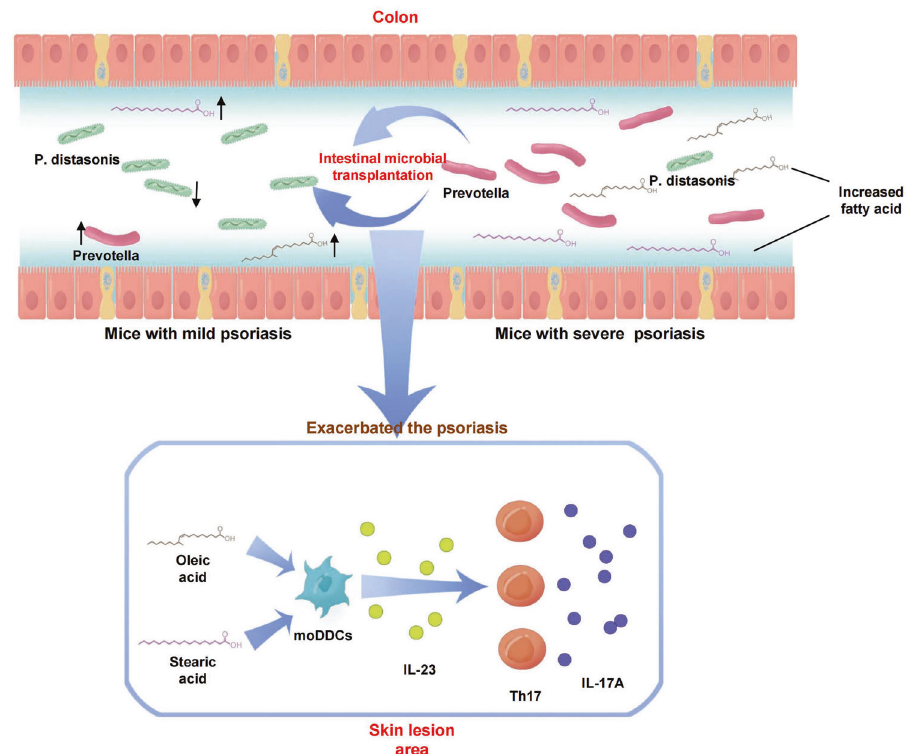
Fig. 9 Schematic representation of the relationship between intestinal microbiota, fatty acid, and pathogenesis of